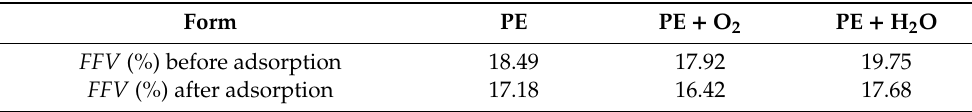
Table 8. FFV of PE cell before and after adsorption.